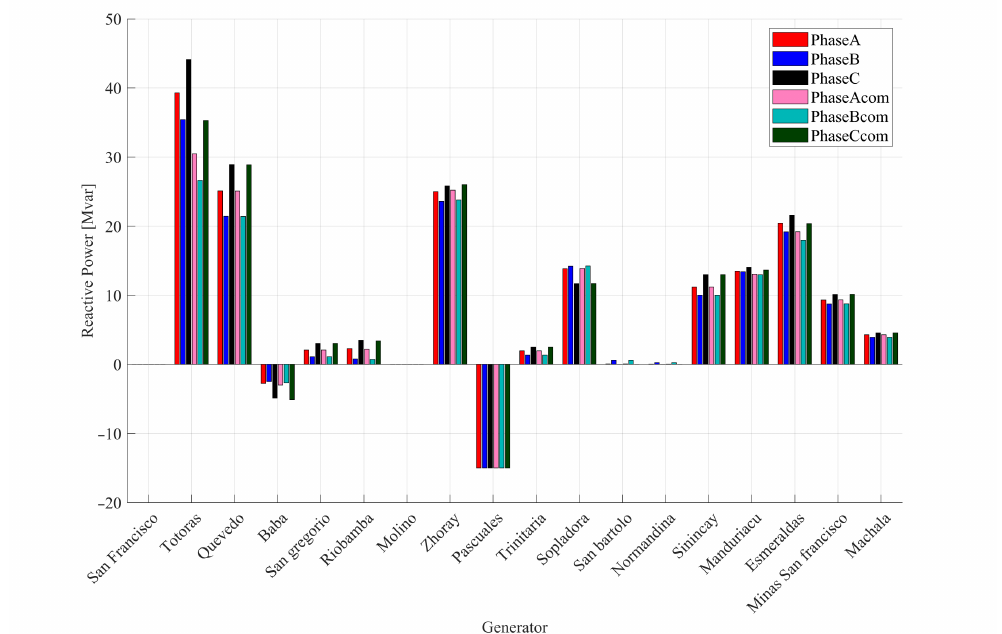
Figure 11. Dispatch of reactive power from